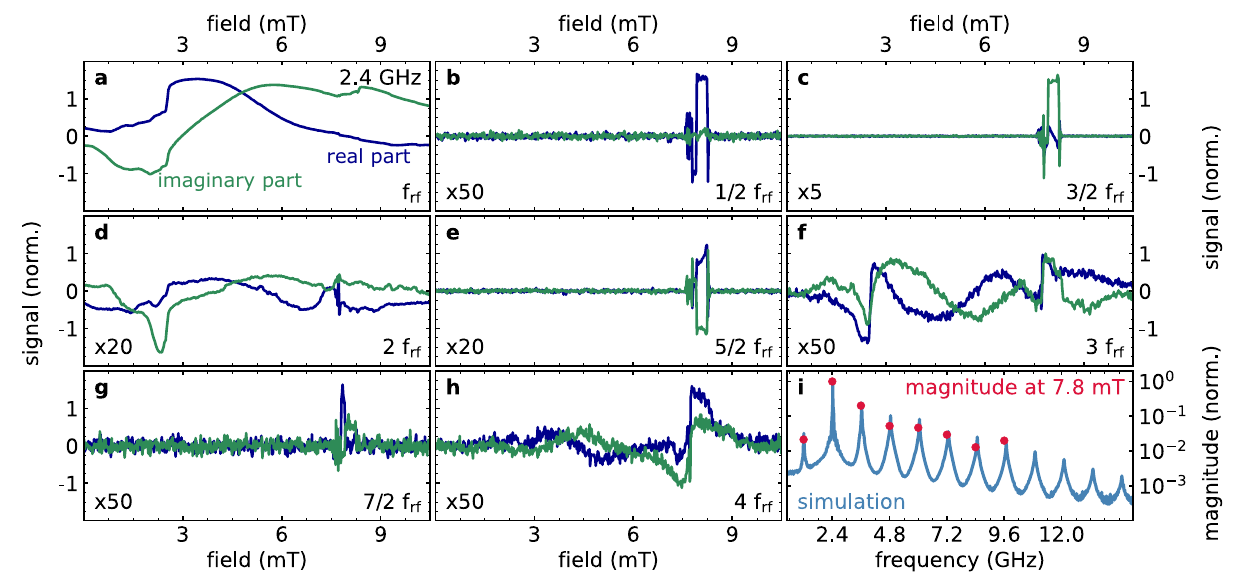
Fig. 2 | Magneto-optical sampling of non-linear spin waves at integer and half- integerharmonics. The30 μ m×15 μ mellipticalelementisexcitedwithalargerf- amplitude at an rf-frequency of 2.4GHz and the non-linear magnetization dynamics are analyzed at different harmonics of the driving frequency as seen in b – g . The real and imaginary part of the uniform mode at f rf normalized to its magnitude is presented in a while integer harmonics at 2 f rf , 3 f rf , and 4 f rf are shown (with corresponding scaling factors) in d , f , and h , respectively. For large